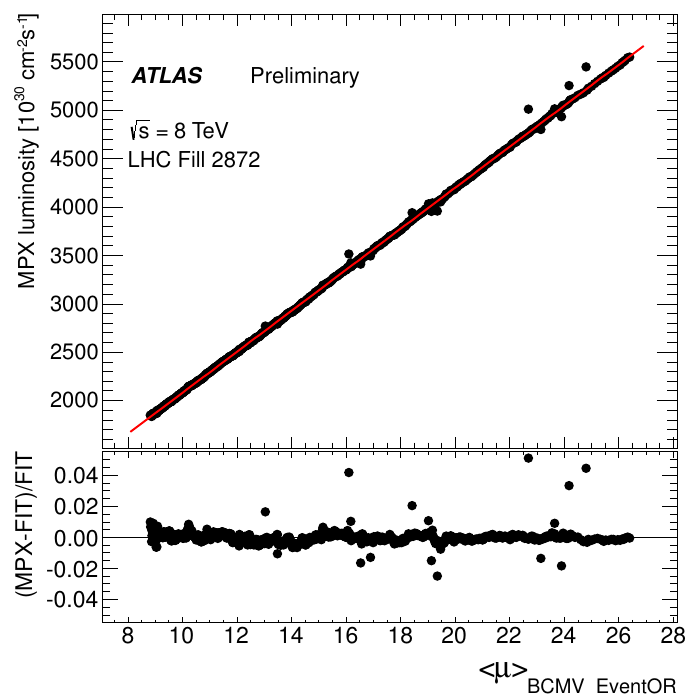
Figure 22. MPX01 hit luminosity vs. bunch-averaged number, (cid:104) µ (cid:105) , of inelastic interactions per crossing reported by the reference ATLAS luminosity algorithm (BCMV_EventOR). This LHC fill was chosen because the data span a particularly wide range of (cid:104) µ (cid:105) values. The residual of a linear fit to the data is shown in the bottom frame. The outliers correspond to times when the LHC operators performed small amplitude beam-separation scans to optimize collisions, during which the luminosity varies more rapidly than can be reliably sampled by the online luminosity and MPX data-taking infrastructure. Taken from Ref.